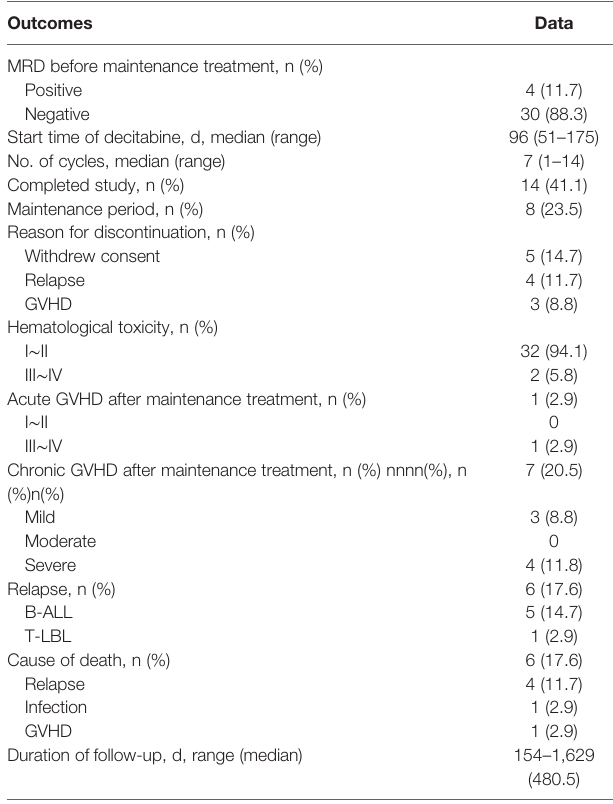
TABLE 2 | Outcomes of transplantation and maintenance treatment (N =